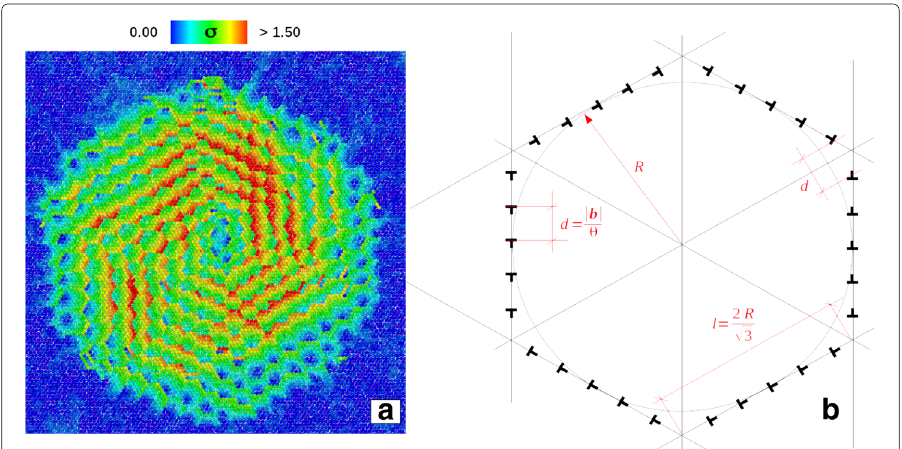
Fig. 9 a Color map of the residual atomic displacement magnitude after the grain disappeared (θ = 10 ◦ ) ; b simplified description of the grain boundary used to develop the toy model of grain boundary